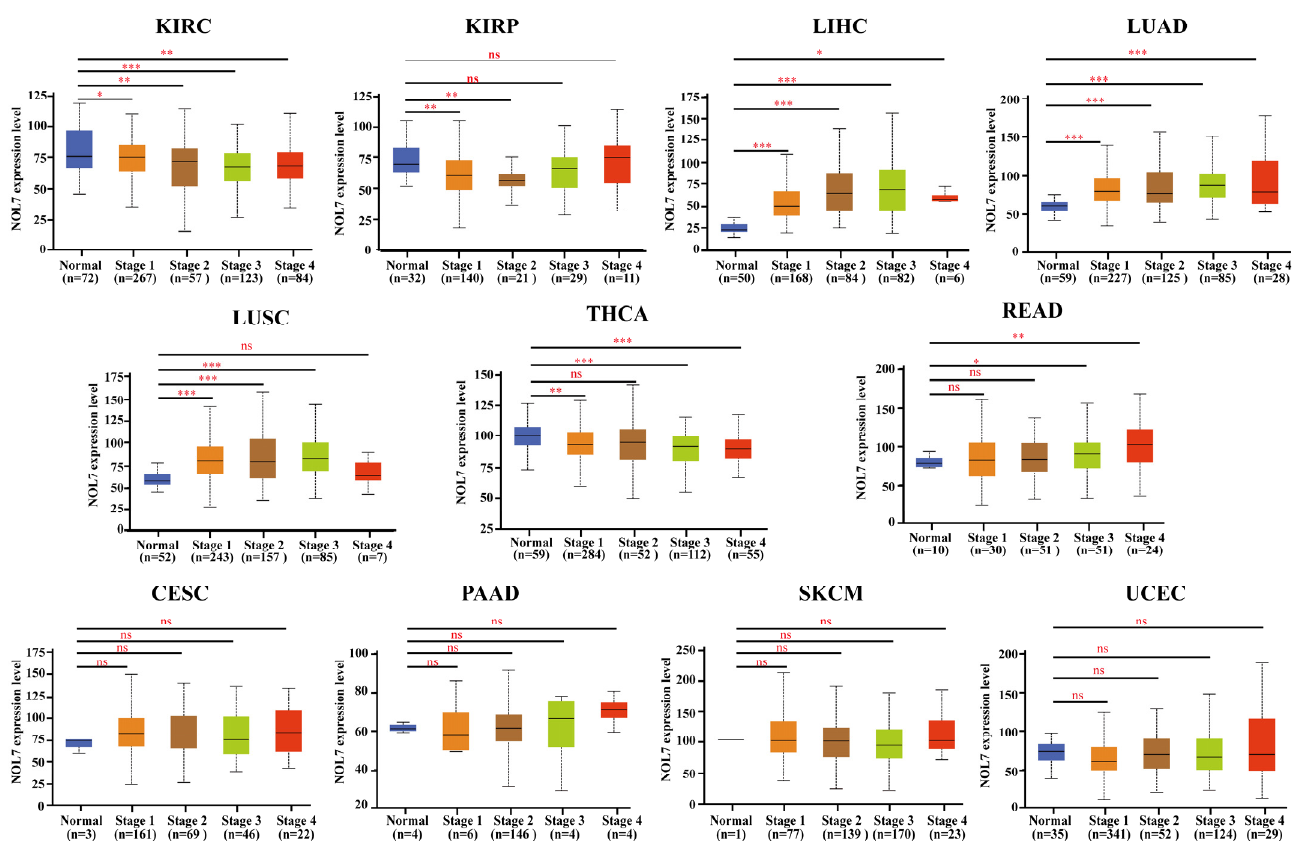
Figure 2. Correlations between NOL7 gene expression and the main pathological stages in normal and stages I, II, III, and IV BLCA, BRCA, CESC, CHOL, COAD, ESCA, HNSC, KICH, KIRC, KIRP, LIHC, LUAD, LUSC, PAAD, READ, SKCM, STAD, THCA, and UCEC tissues, as examined using the TCGA dataset. * p < 0.05; ** p < 0.01; *** p < 0.001; ns No